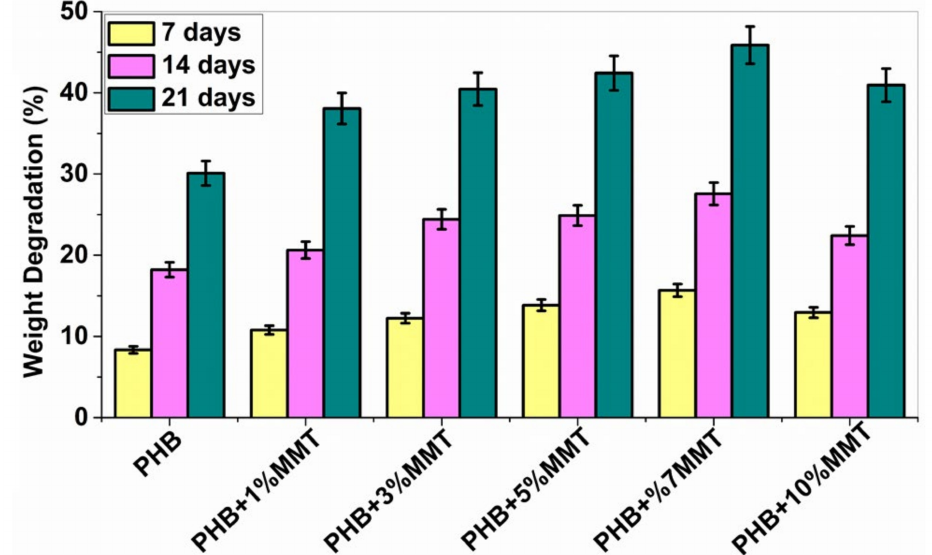
Figure 7. Graph showing % weight degradation of the different films by